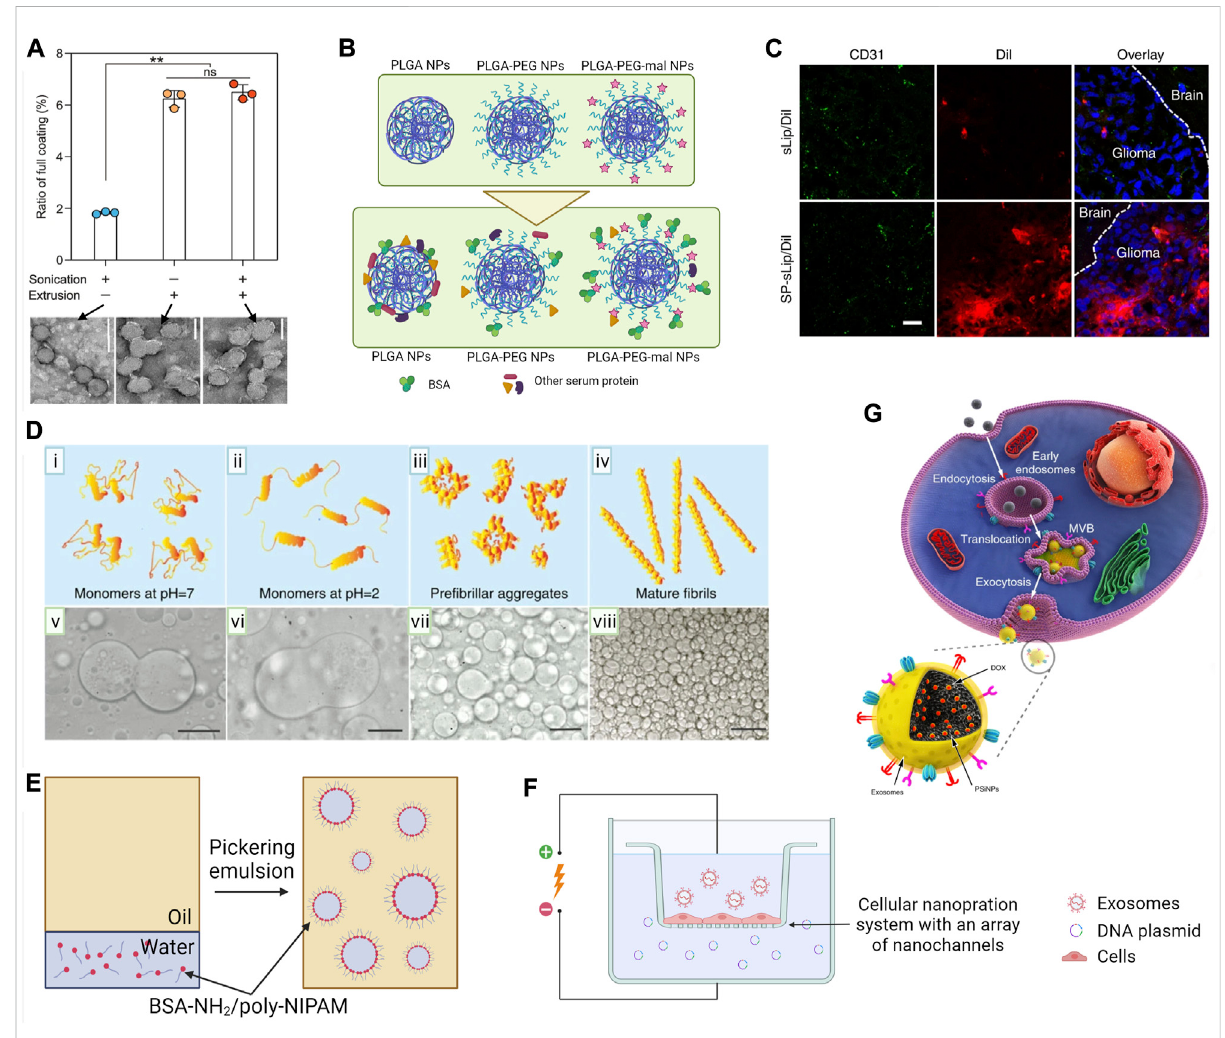
FIGURE 3 Surface modi fi cation techniques of micro- and nano-scale biomaterials. (A) Ratio of full CM coating accomplished with either sonication, extrusion, or combined sonication-extrusion and TEM images of each sample. Scale bars, 100 nm; by Liu et al. (2021) licensed under CC BY 4.0. (B) Schematic illustration of the in situ coating protein on PLGA NPs in vivo . Bare, PEGylated (PLGA-PEG), and maleimide-conjugated (PLGA-PEG-mal) PLGA NPs (at top) will acquire a protein corona during in vivo circulation (at bottom). Protein corona of PLGA-PEG-mal NPs was enriched with albumin that was covalently conjugated to maleimide motifs (Li et al., 2018d). (C) Confocal microscope images of brain slices at 4 h after liposome administration via the tail vein of nude mice bearing intracranial glioma. Brain slices were stained with the anti-CD31 antibody (green) and biodistribution of liposomes (red) in normal brain tissues (labeled with the brain) and glioma region (labeled with glioma) by Zhang et al. (2019) licensed under CC BY 4.0. (D) Stability of dextran-in-PEG emulsions by adding lysozyme in different aggregation stages as (i – iv) graphical representation of lysozyme aggregation state and (v – viii) corresponding optical micrographs showing stabilization behavior. Scale bars, 50 µm by Songetal.(2016)licensedunderCCBY4.0. (E) Procedureforpreparationofwater-in-oilproteinosomesusingBSA-NH2/PNIPAAmnanoconjugates. An aqueous suspension of amphiphilic BSA-NH2/poly-NIPAM nanoconjugates was emulsi fi ed in a continuous oil phase. Nanoconjugates spontaneously self-assembled around water-in-oil emulsions to produce stabilized protein-based spherical microcompartments (Huang et al., 2013). (F) Schematic representation of nanoporation-based exosome generation. A monolayer of parent cells will culture above an array of nano- channels (approximately 500 nm in diameter). Plasmid DNA in the buffer enters the attached cells through nanochannels under transient electrical pulses. Attached cells subsequently release large quantities of exosomes containing transcribed mRNA (Yang et al., 2020). (G) Schematic illustration ofthepreparationofEM-coated NPs(PSiNPs).PSiNPsareendocytosedintocancer cellsafterincubation,andthenlocalizedinmultivesicularbodies (MVBs) and autophagosomes. After MVBs or amphisomes fuse with the cell membrane, EM-coated PSiNPs are exocytosed by Yong et al. (2019) licensed under CC BY